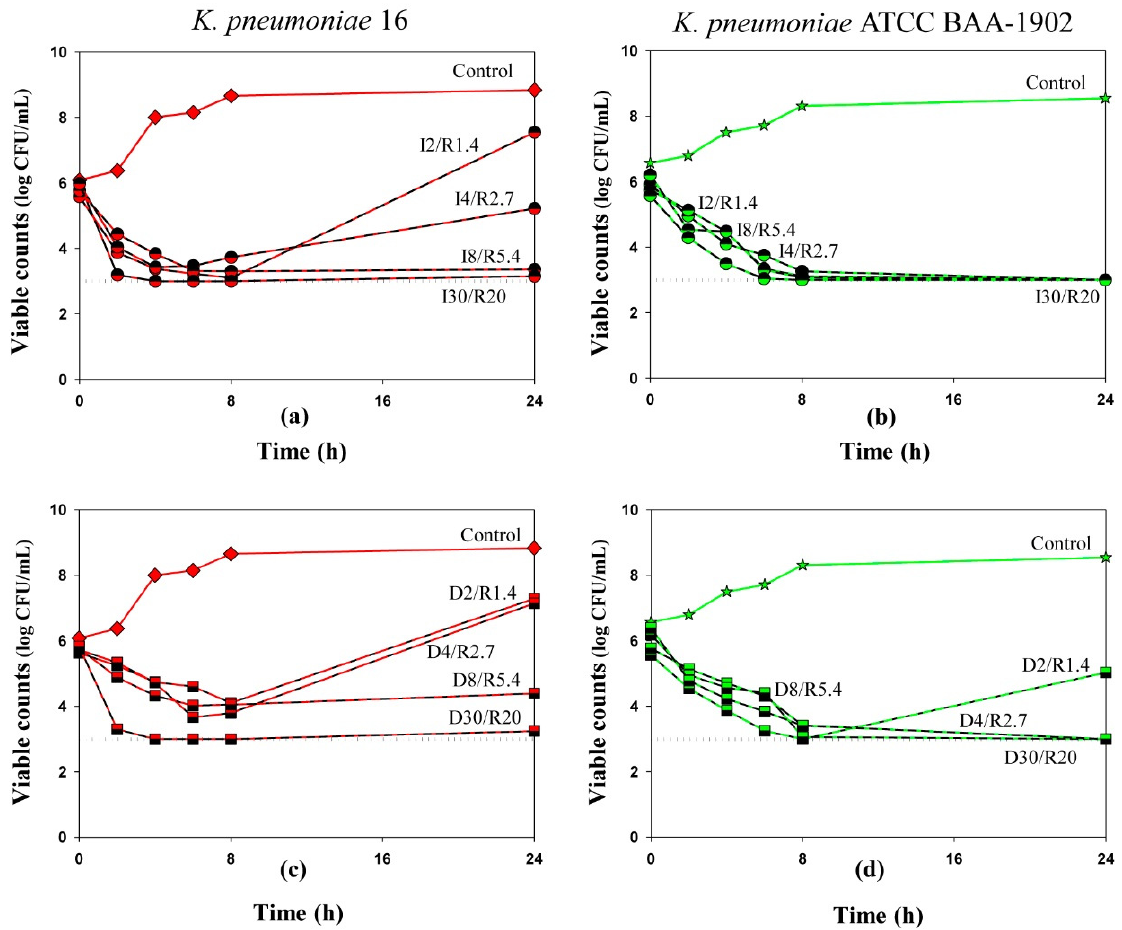
Figure 1. Time-kill curves of imipenem ( a , b ) and doripenem ( c , d ) used in combination with relebactam against K. pneumoniae . Dosing regimens are indicated at each curve. Dotted lines indicate the limit of detection. Data are presented as arithmetic means. Standard deviations are not shown as the data point difference was negligible.